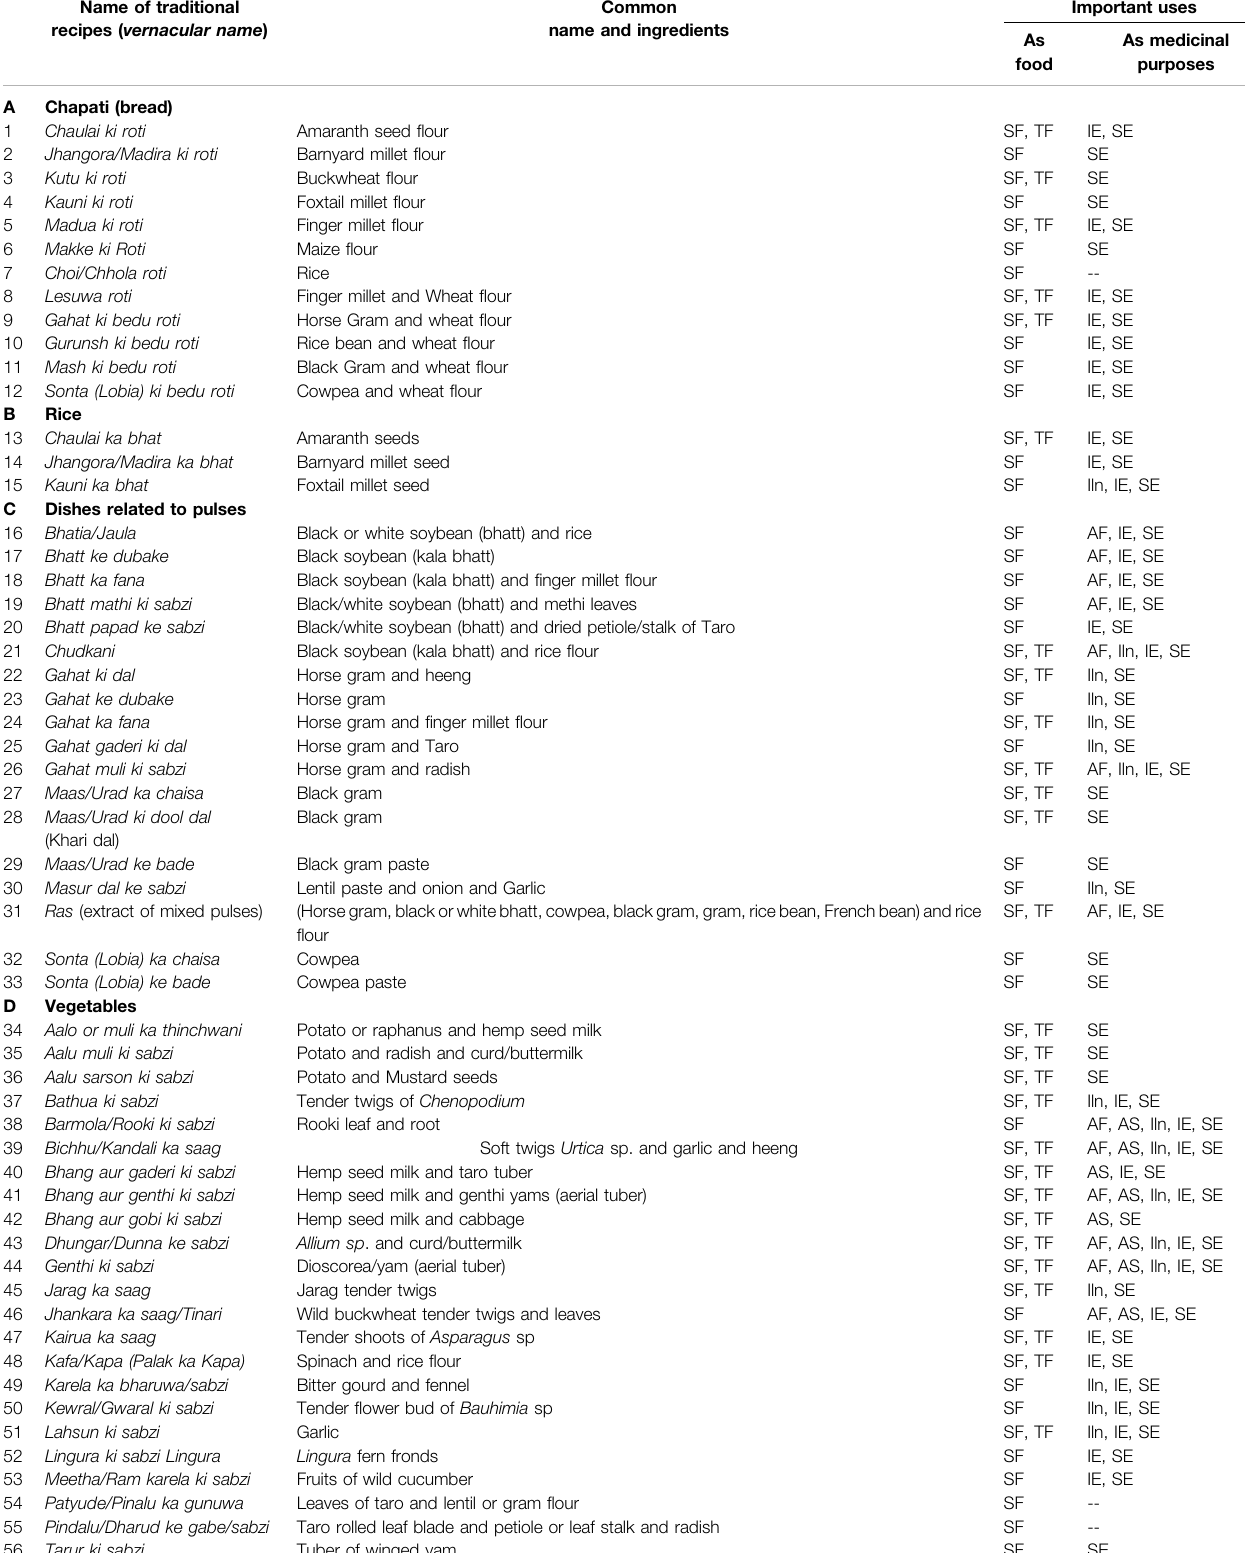
TABLE 6 | Traditional recipes with major ingredients and its special uses in the central